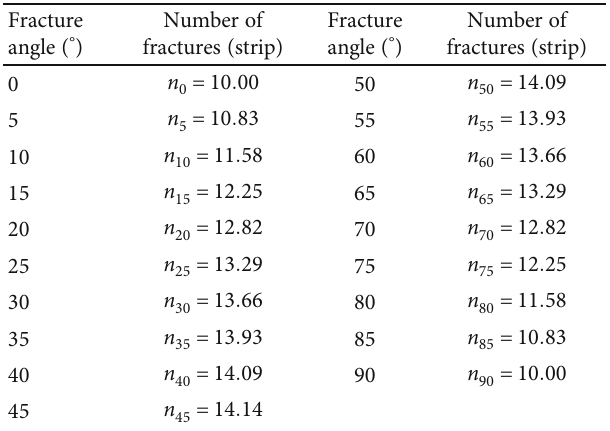
Table 1: Number of fractures in the models with di ff erent fracture angles.